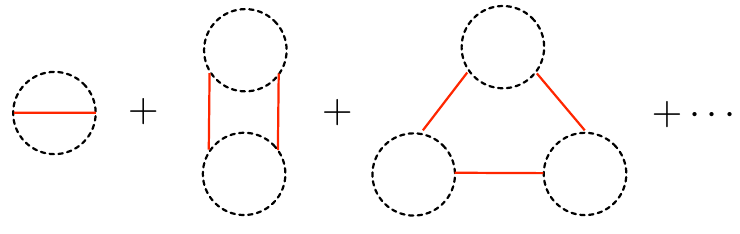
Figure 7 . Ring diagrams contributing to V